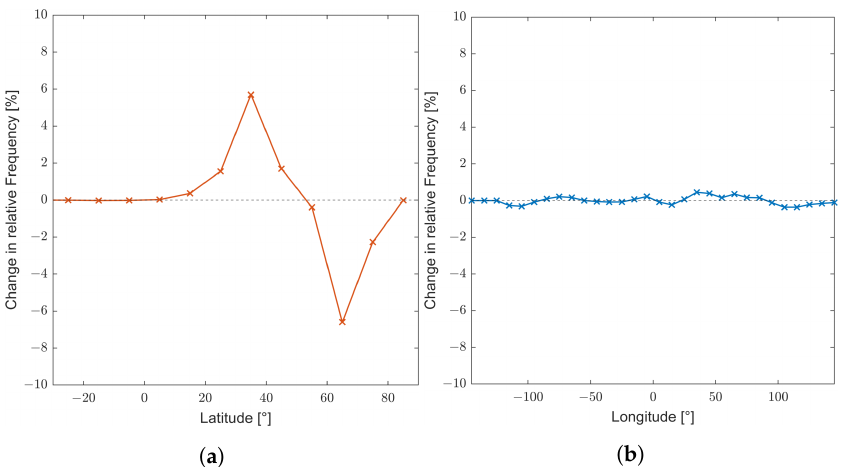
Figure 7. Latitude ( a ) and longitude ( b ) along resulting routes: difference between climate-optimised and fuel-optimised ISO set-up. Positives values indicate a higher share in the climate-optimised case, negative ones, a higher frequency in the fuel-optimised case.